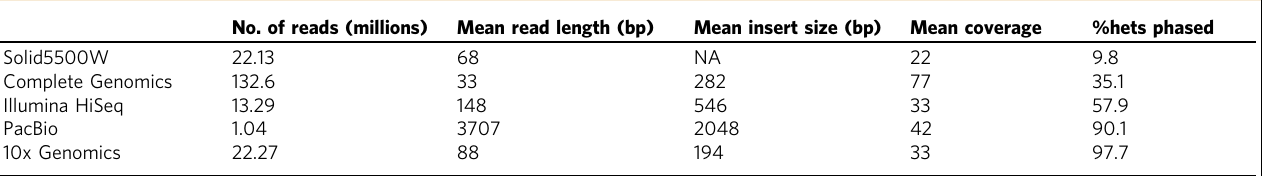
Table 1 Summary statistics for GIAB sequencing